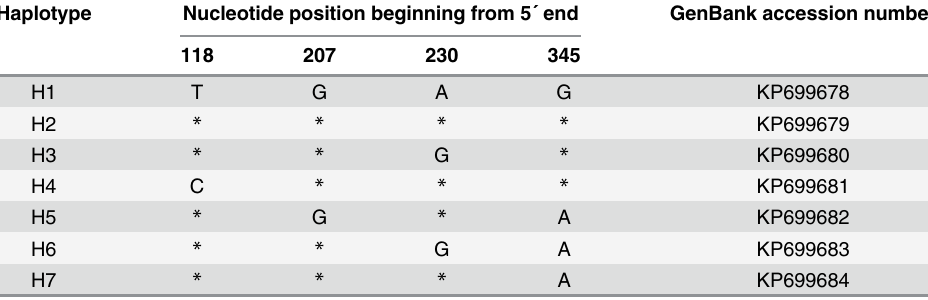
sequenced from 61 samples, and 4 polymorphic sites and 7 haplotypes were detected. Two hap- lotypes (H1 and H2) were found to be shared by ZS and ZP populations; the rest were popula- tion specific haplotypes (Table 4). In addition, 496 bp of the ND1 gene was sequenced using 65 specimens, and 5 polymorphic sites and 6 haplotypes were detected. H1 and H2 were shared among all 3 populations; H3 was observed in ZS and BH populations; H4 and H5 were specific for the BH population (Table 5). Haplotype diversity ( h ) and nucleotide diversity ( π ) based on COI, 12S rRNA, and ND1 genes for the 3 populations are listed in Table 1. Not all of Tajima ’ s D results for the 3 genes were significant ( p > 0.05; Table 6), indicating results for the 3 balanced selection and/or a decrease in population size [18]. Most of Fu ’ s F S genes were not significant ( p > 0.05; Table 6), except F results for the COI gene in the ZS S Table 4. Variable Positions of 7 Haplotypes of 12S rRNA in Macridiscus multifarius .